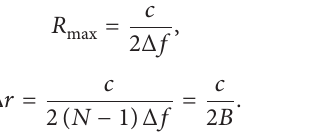
is the frequency step. Figure 4 depicts how the transmitted signals are generated.